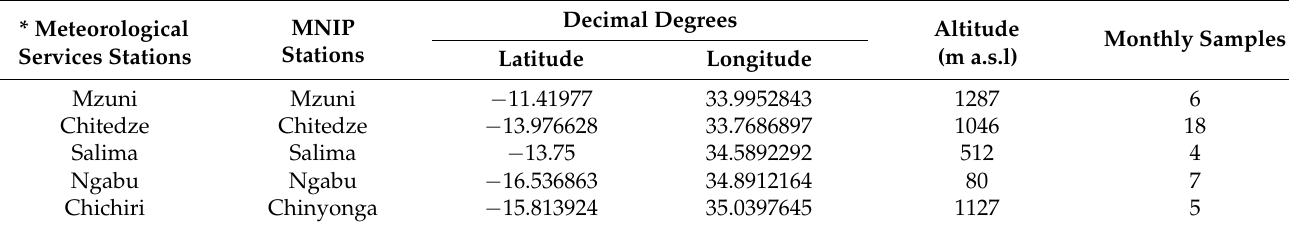
Table 1. Summary of isotopic sampling undertaken from Malawi Network of Iso–topes in Precipitation (MNIP) Stations (1914–2019).